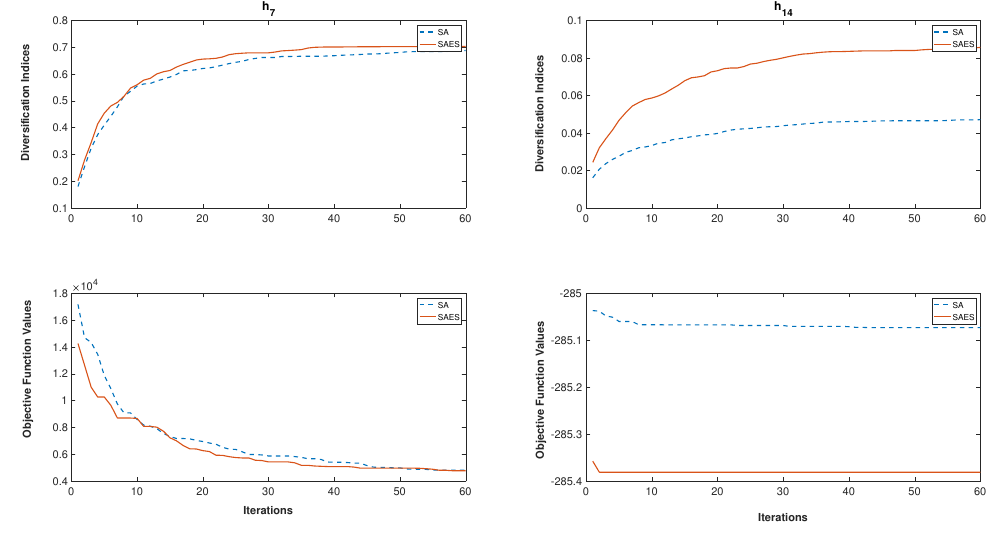
Figure 8. Examples of the SA and SAES diversification performance using hard test